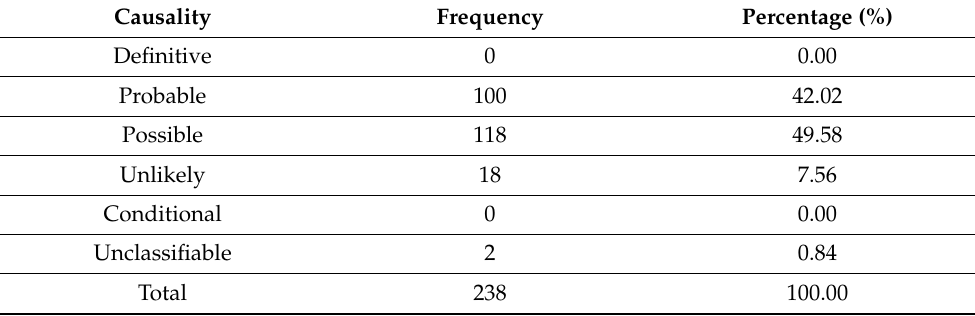
Table 4. Characterization of Adverse Drug Reactions according to the degree of causality at- tributed.